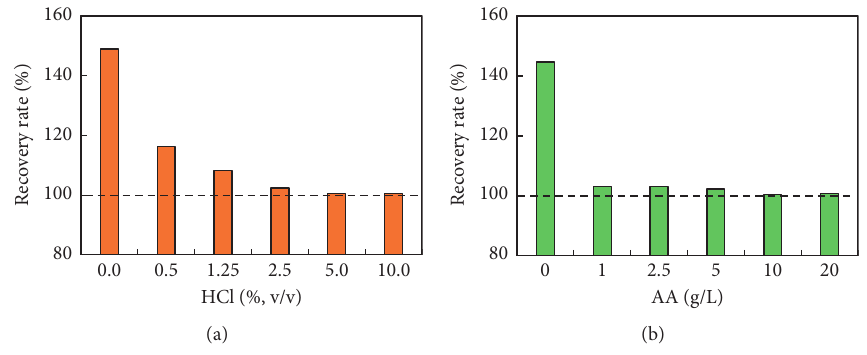
Figure 6: (a) Optimization of HCl dosage. (b) Optimization of AA